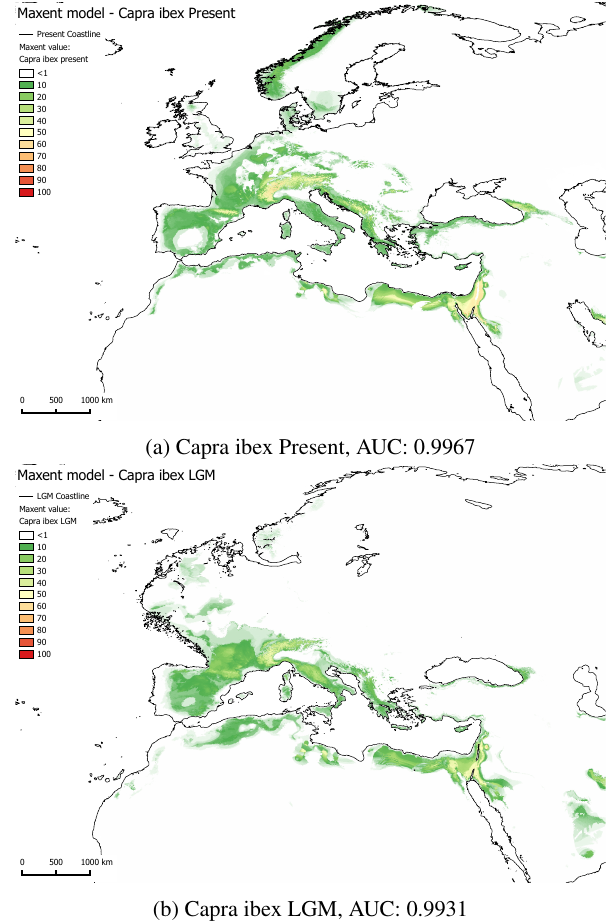
Figure 4: Maps showing modelling results for Capra ibex with Maxent values